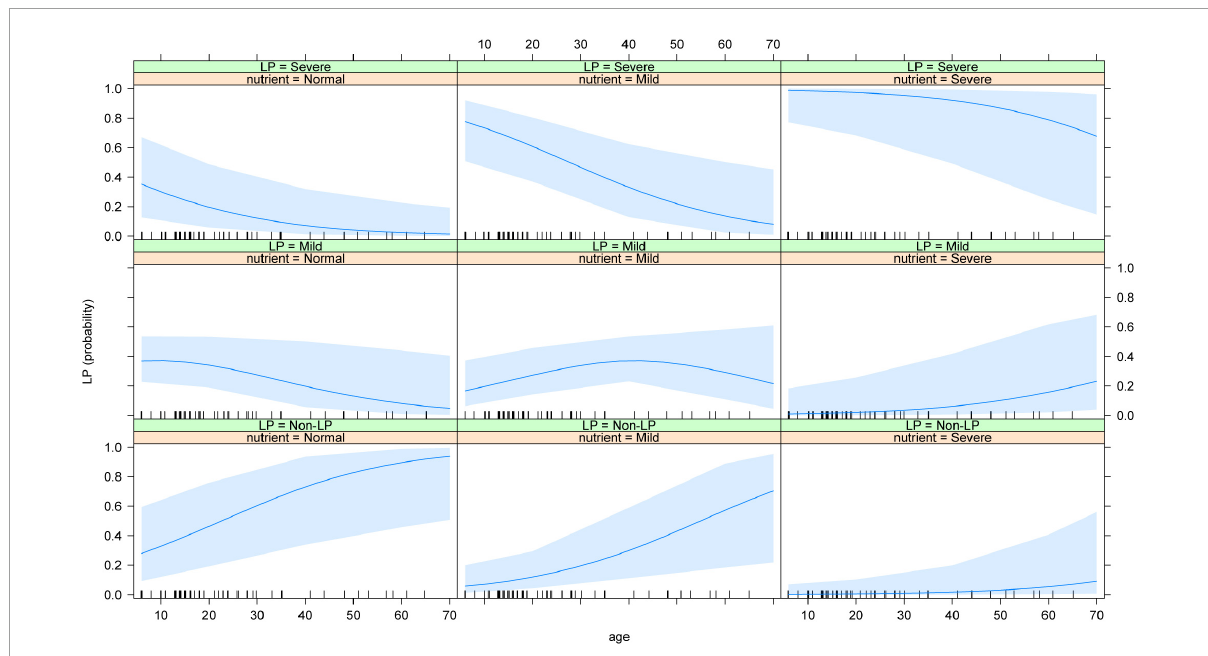
FIGURE4 Joint effect of age and the nutritional status on the risk of LP. The results showed that the risk of severe LP increased with the increased age and the worse nutritional status. LP: